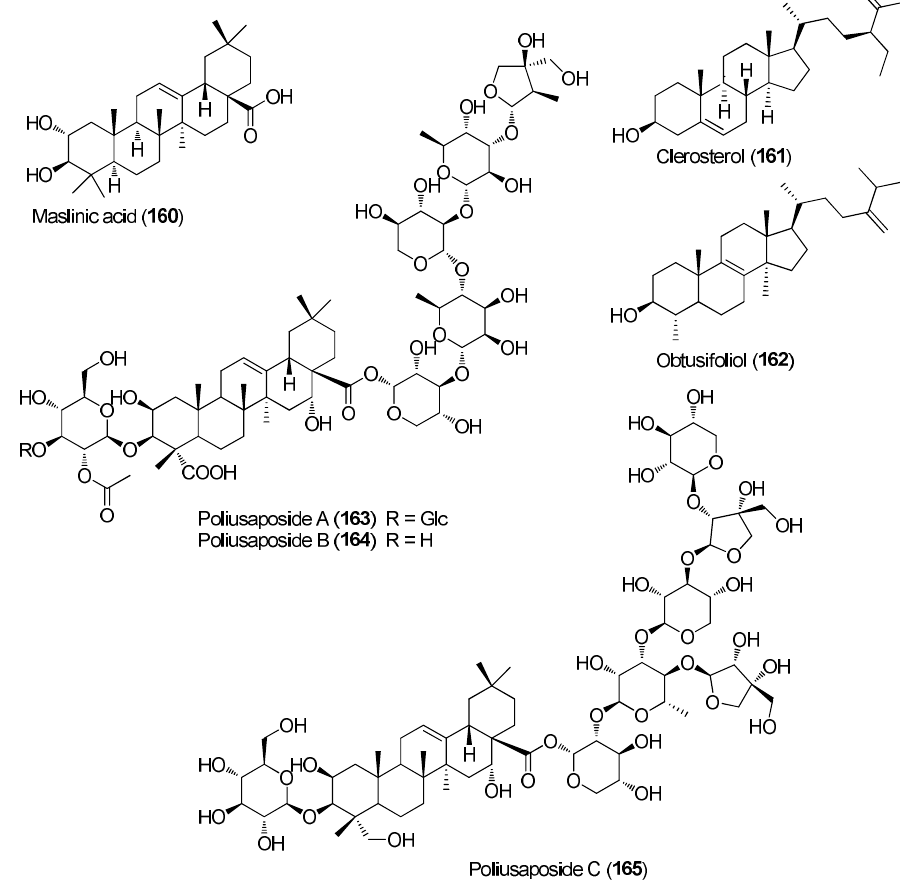
Figure 11. Representative triterpenoids and sterols isolated from Teucrium polium.